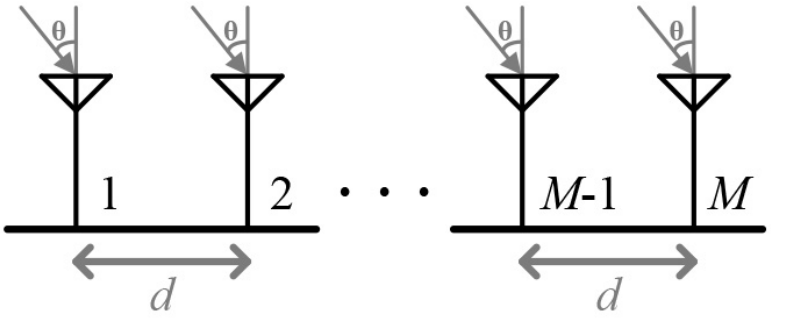
Figure 1. Uniform linear array